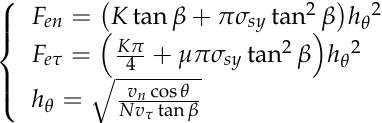
Figure 3. Force model of a single abrasive particle.